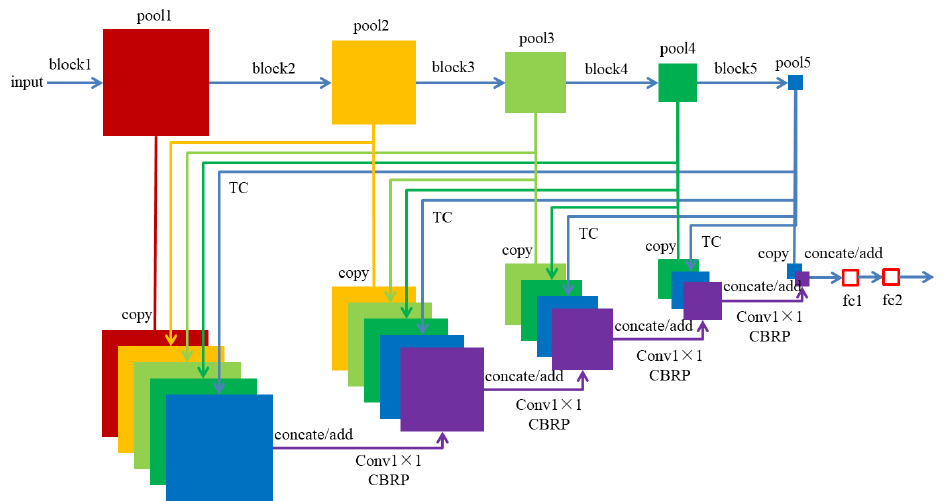
Figure 4. CDTNet architecture.